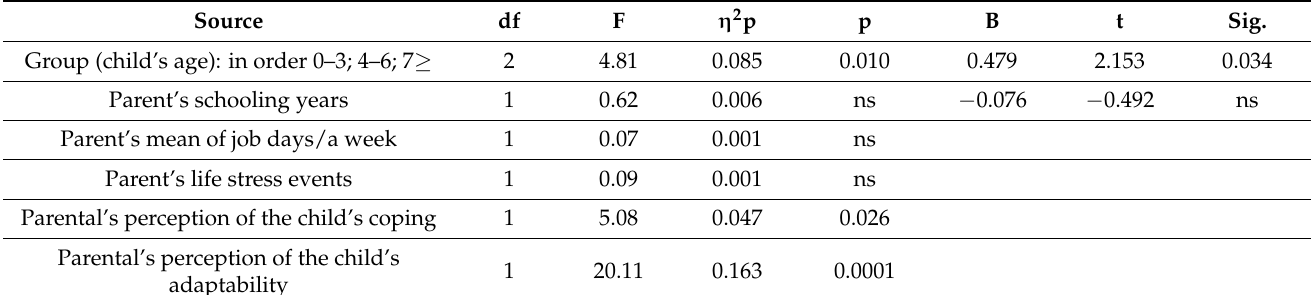
Table 2. ANCOVA comparing parenting between the three categories of the child’s age controlling for demographic factors and parental perception of the child’s